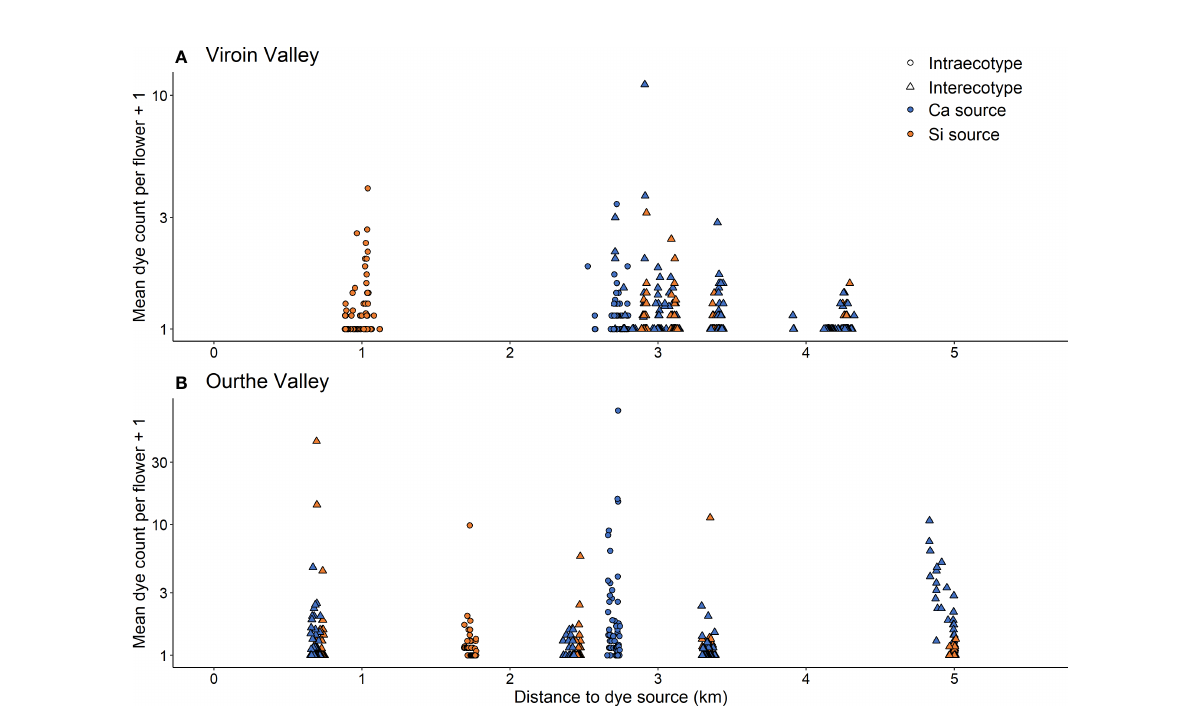
FIGURE 5 Mean dye count per fl ower (axis in log-scale) or each recipient individual and dye source in function of the distance to dye source for interpopulation dye transfers between four calcicolous (Ca) and silicicolous (Si) populations of Silene nutans populations in (A) Viroin Valley and (B) Ourthe Valley. Circles = intra-ecotypic transfers (blue, Ca; orange, Si); triangles = inter-ecotypic dye transfers (blue: Ca to Si; orange: Si to